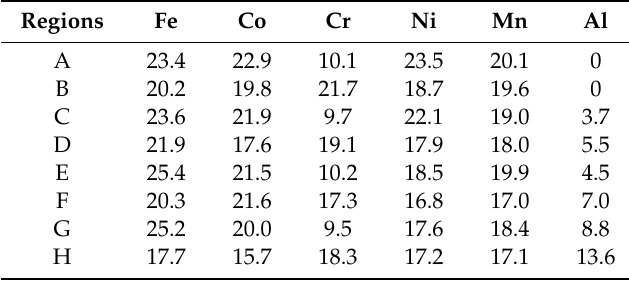
Table 2. EDS detection results of dendritic and interdendritic spaces of FeCoCrNiMnAl x cladding layers (at.%).